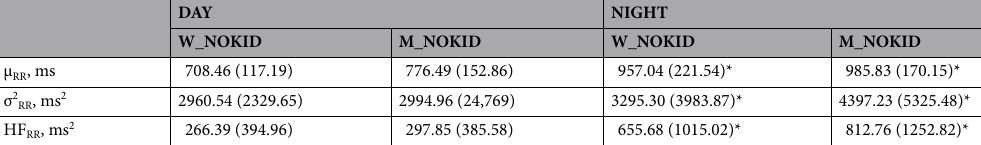
Table 3. Results of the cardiac autonomic profile comparison between W_NOKID and M_NOKID during DAY and NIGHT. DAY, daytime; NIGHT, nighttime; W_NOKID, women without children in preschool age; RR , power of RR series in the HF band. Results are presented as median. In bracket the interquartile range, calculated as the difference between the first and the third quartile is presented. * indicates p < 0.05 DAY versus